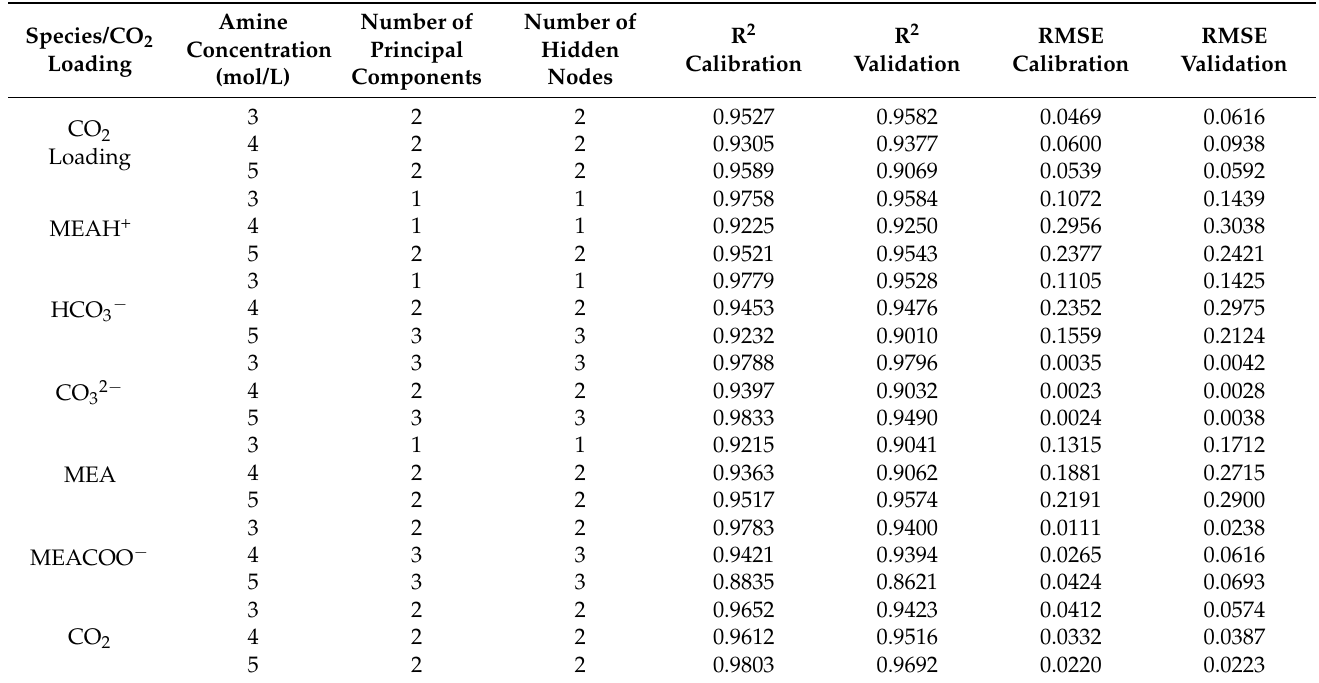
Table 4. Summary of performance evaluation results for artificial neural network (ANN)-based Raman species calibra- tion models.